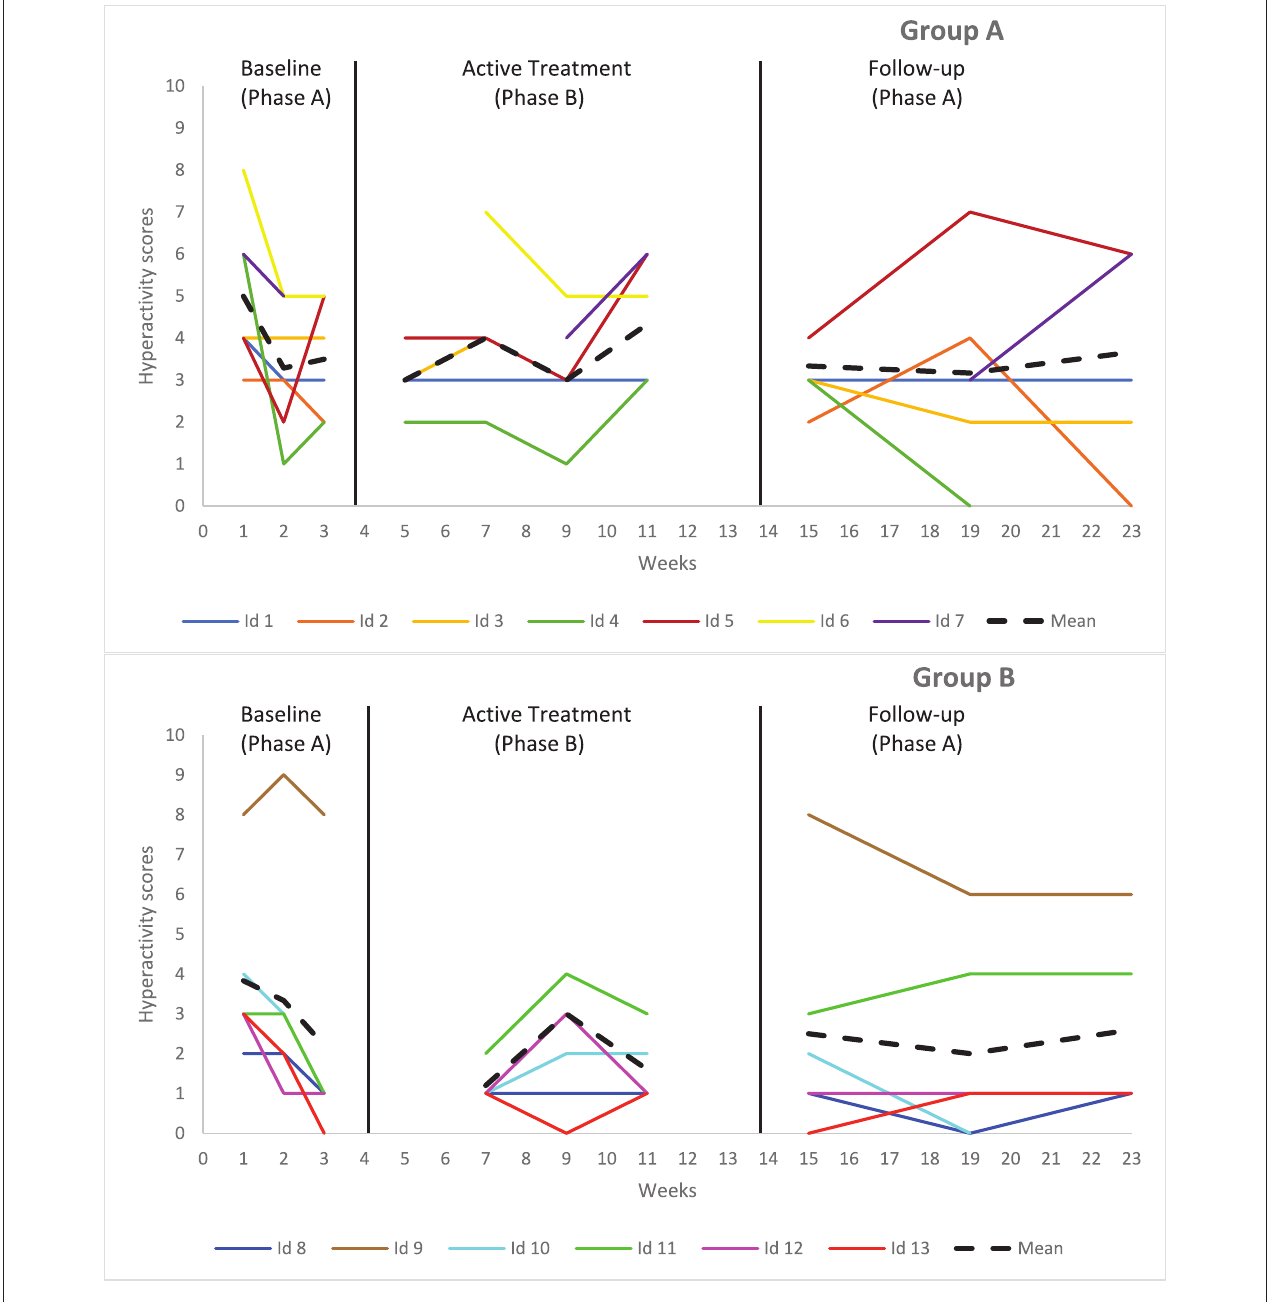
FIGURE 4 | Graphical display of baseline level and changes in level between consecutive phases in hyperactivity for self-reported data.